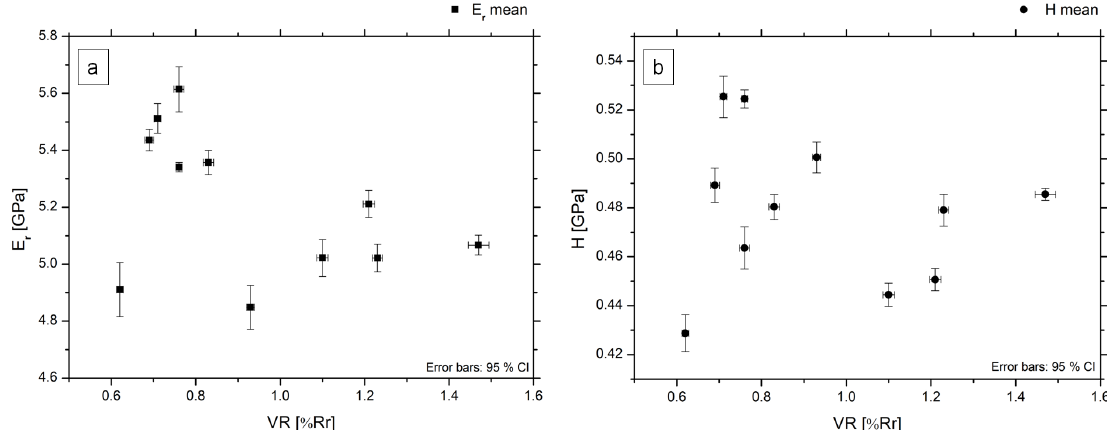
Figure 4. E r (a) and H (b) obtained for vitrinites from 11 samples with varying maturity (0.62 to 1.47%Rr). (CI = Confidence